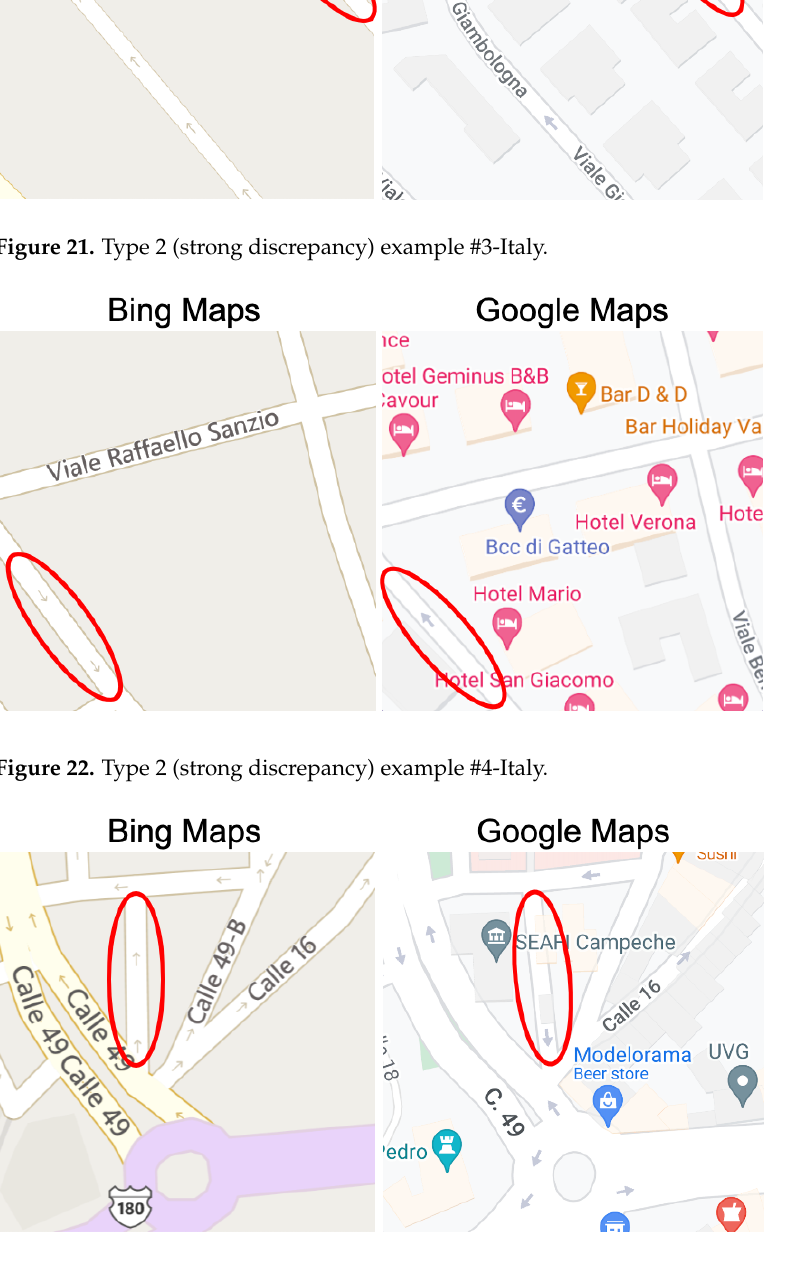
Figure 23. Type 2 (strong discrepancy) example